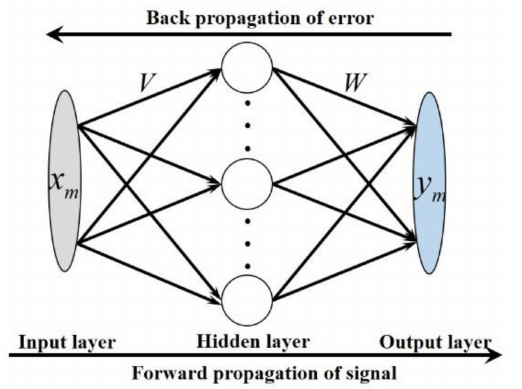
Figure 4. The structure of the triple-layer BP neural